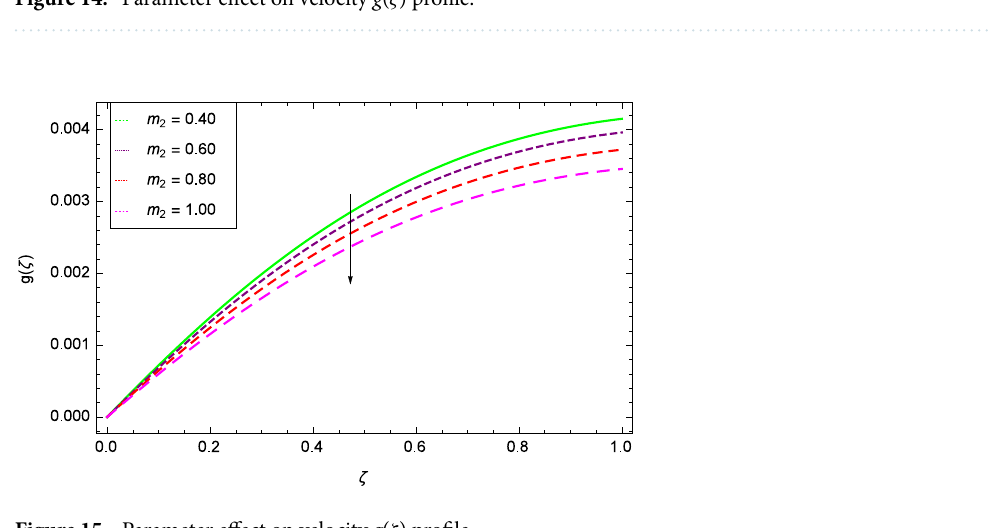
Figure 15. Parameter effect on velocity g ( ζ )